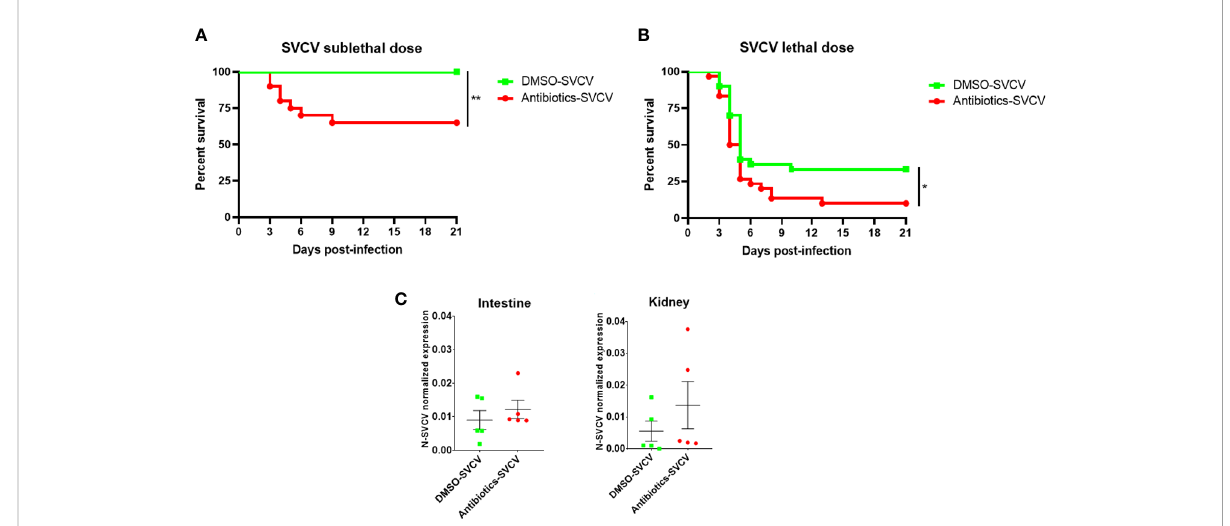
FIGURE 3 The long-term exposure of zebra fi sh to SMX+CLA conditions their resistance to SVCV. Kaplan − Meier survival curves of SMX+CLA- or DMSO- treated fi sh infected with a (A) sublethal or (B) lethal dose of SVCV. Statistically signi fi cant differences are displayed as ** (p<0.01). No mortality events were registered for the uninfected fi sh. (C) qPCR detection of the SVCV N gene in the intestine and kidney of zebra fi sh infected with SVCV at 24